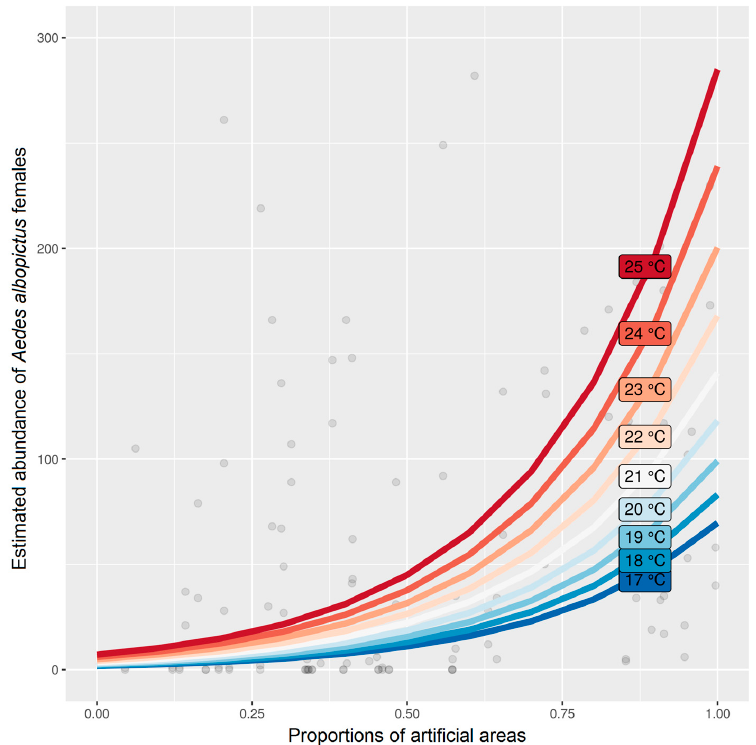
Figure 3. The coloured lines represent the simulated abundance (applying the most parsimonious model) of Ae. albopictus females collected in eight trap nights between June and September with respect to the proportion of artificial areas, while varying the temperature of the warmest quarter across its range in the study area (the curves take into account the two explanatory fixed effects, but not the trap random effect included in the negative binomial mixed models). In the background, we reported (as points) the total abundance of adult females observed in each sampling location as a function of the artificial area in a 250 m buffer. The y axis was limited at 300 adult females for graphical reasons.